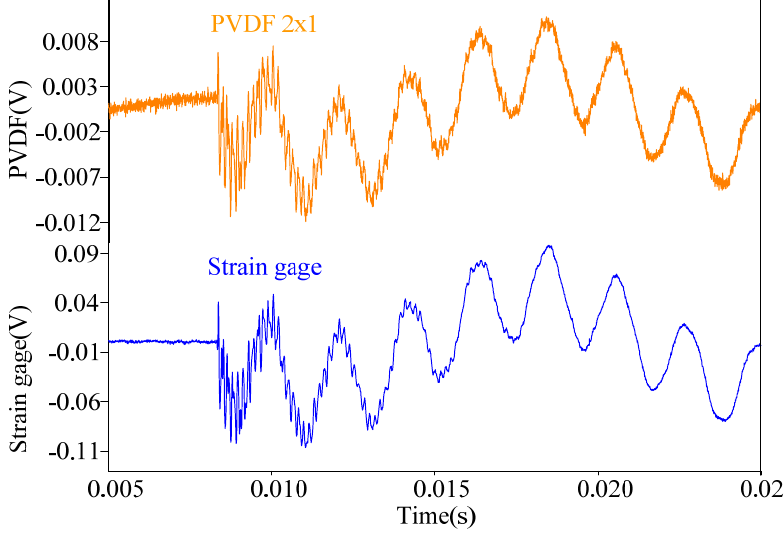
Figure 19. Measurement results of PVDF 2  1 and the strain guage with impact on location